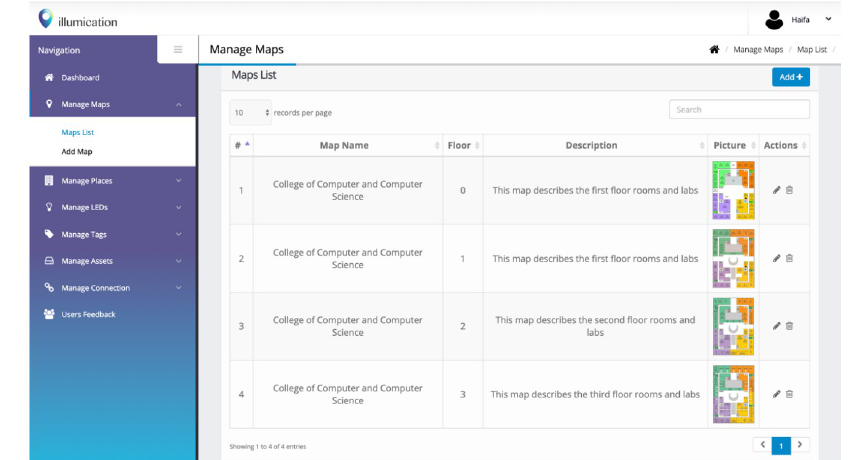
Fig 5. Web panel of the illumication system.